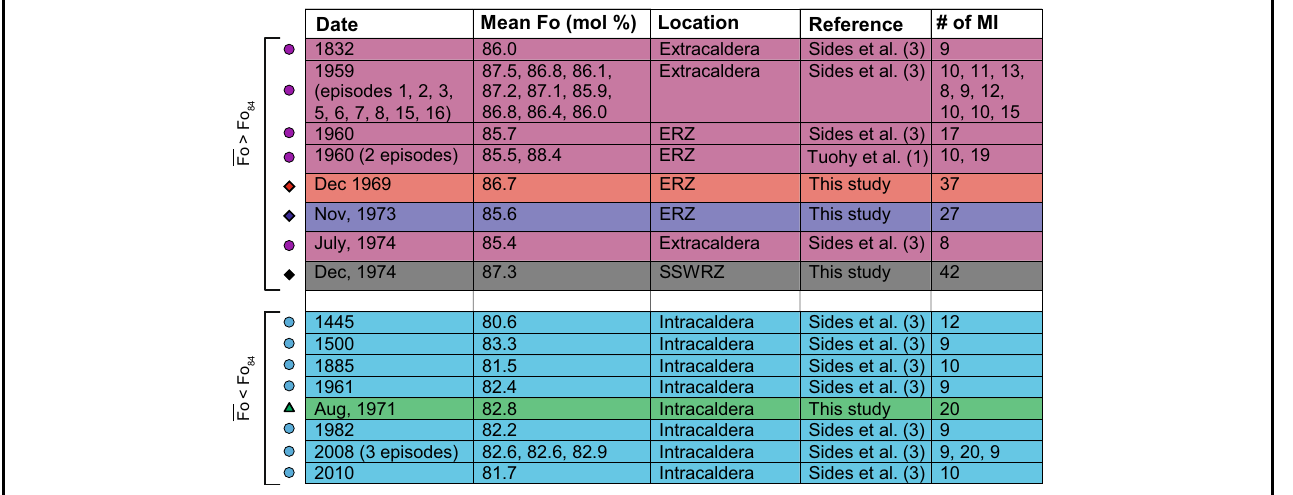
The symbol next to each row, and the row color, shows the classi fi cation of eruptions used in Figs. 1 – 4. Date: date of eruption for each sample (CE). Nine episodes of the K ī lauea Iki eruption, and 2 episodesof the1960Kapohoeruption(samplesKap6andKap8fromref.1)wereused.MeanFo(mol%)mean forsteritecontentof olivinesineachsample(calculatedas100XMgO mol% /(FeO mol% + MgO mol% ); Location: site of eruption (ERZ – East Rift Zone, SSWRZ – Seismic South West Rift Zone). Reference with the number referring to the list of references at the end of this